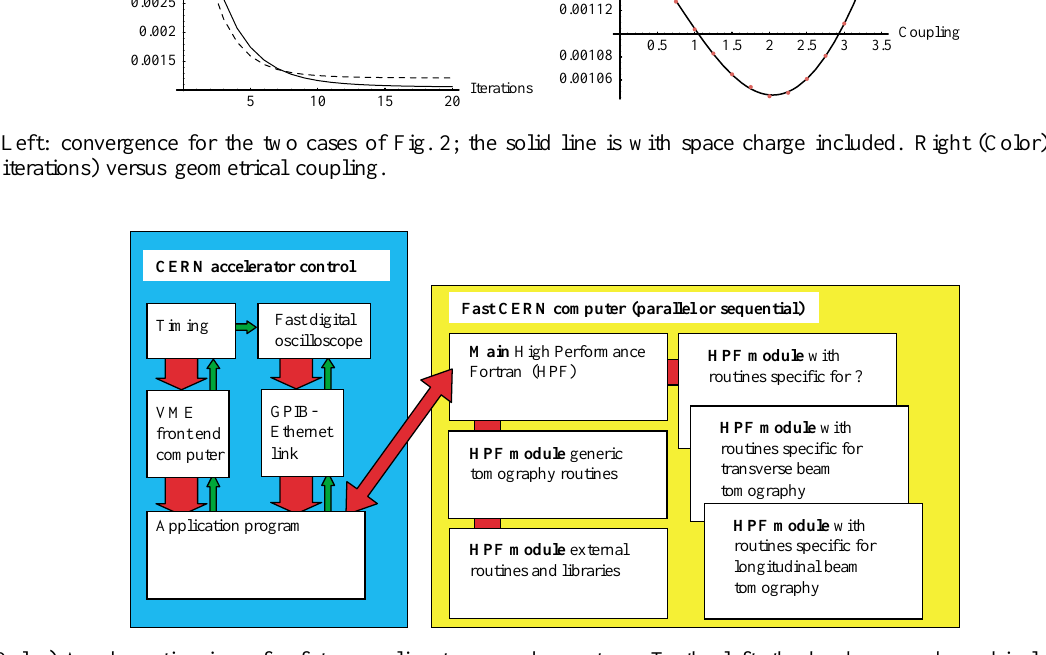
FIG. 4. (Color) A schematic view of a future on-line tomography system. To the left, the hardware and graphical user interface (GUI) configuration is drawn, and, to the right, the structure of the present numerical part of the code. The data flow is indicated with broad arrows and the command flow with narrow